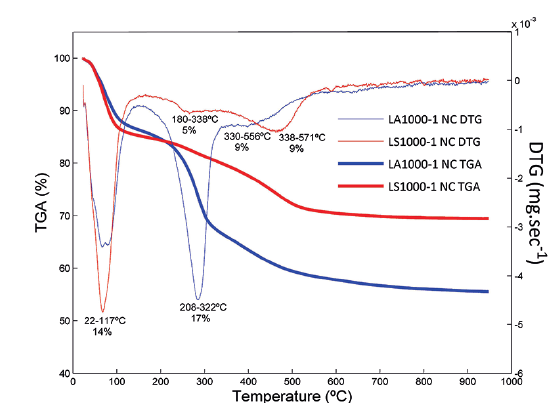
Figure 1: TGA and DTG profiles: LS1000-1 and LA1000-1, non- calcined (NC).